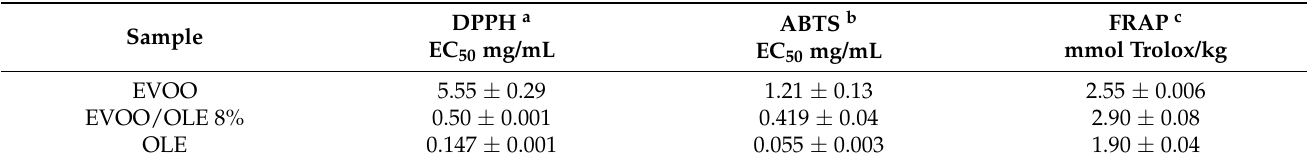
Table 2. Antioxidant capacity of EVOO and EVOO/OLE 8% measured by DPPH, ABTS, and FRAP